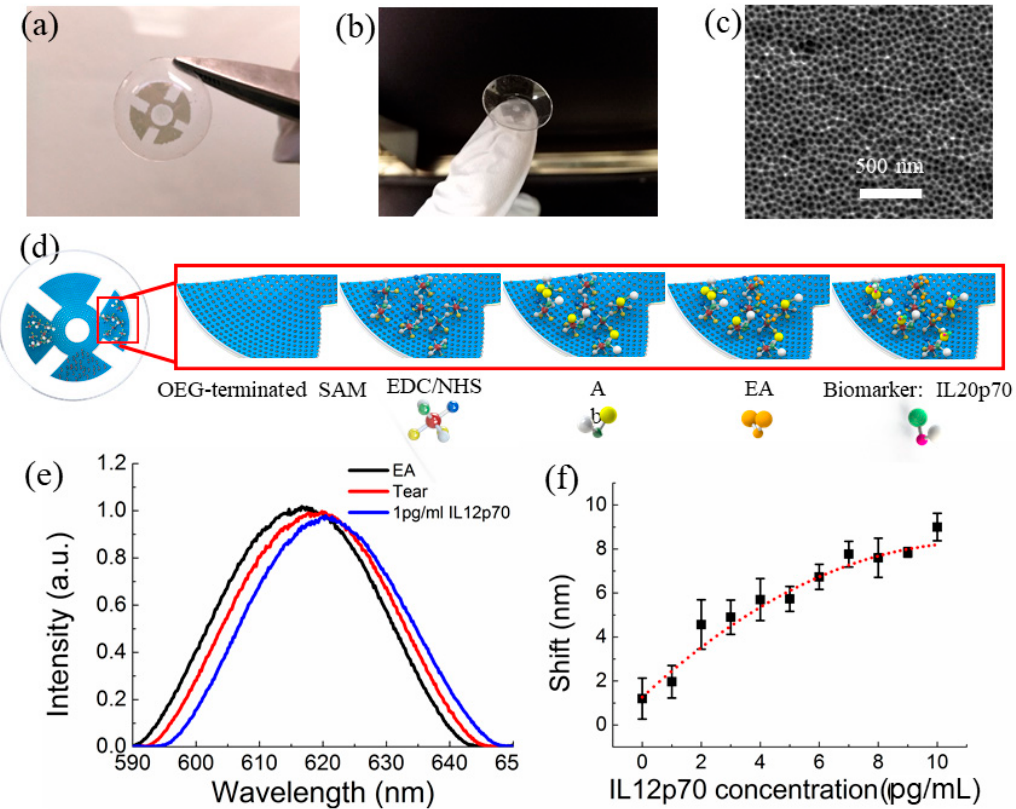
Figure 14. ( a , b ) Contact lens with embedded sensors for detection of glaucoma biomarkers; ( c ) SEM images showing the nanopore in the sensors; ( d ) surface functionalization of the sensors on contact lens; ( e ) representative measured optical signals from a sensor on the contact lens with artificial tear and 1 pg/mL IL 12p70 spiked in artificial tear and ( f ) measured optical signals from the sensor with increased concentrations of IL 12p70 in artificial tear. Reproduced from reference [106] with permission from IEEE.